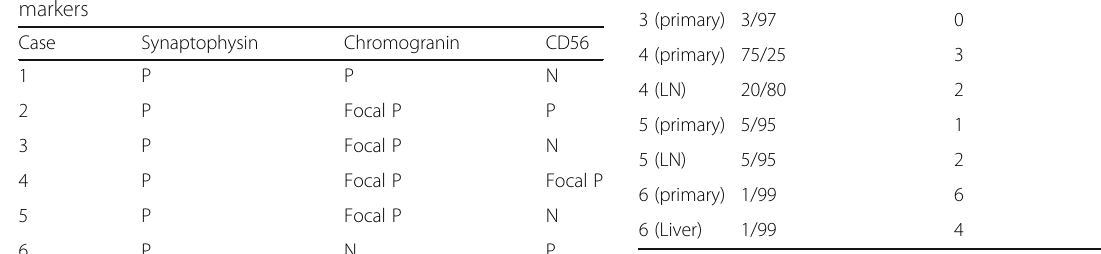
Focal P focal positive, N negative, P positive;